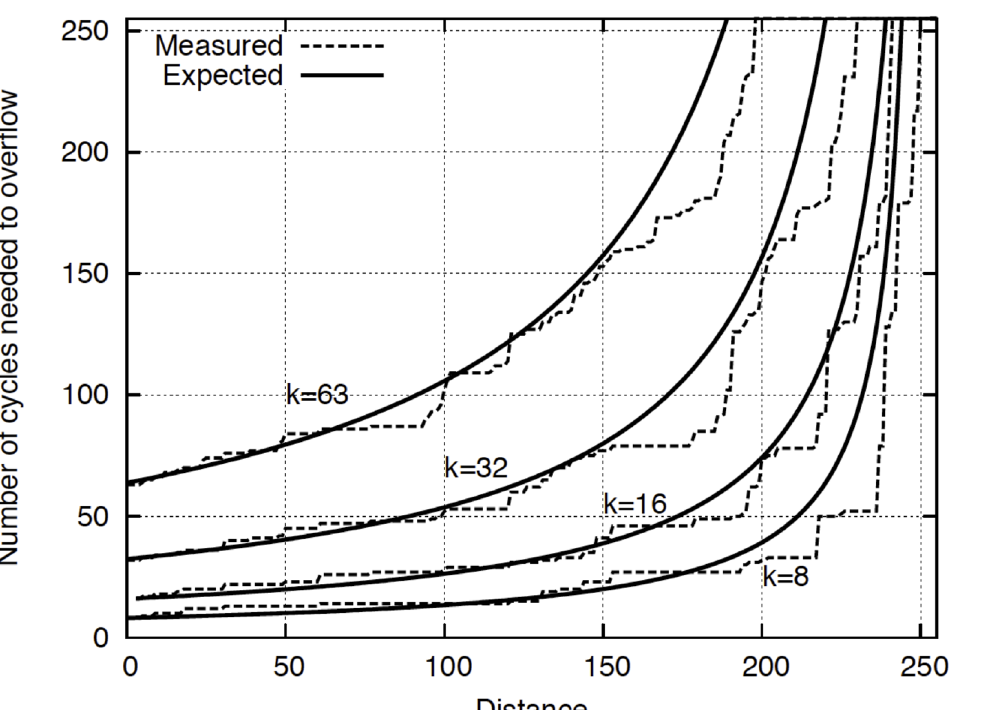
Fig 10. Relationship of distance between vectors (| x-y |) and the number of cycles needed to overflow a module-k counter of the WTA. The switching activity of the similarity stochastic signal ( s jr ) is dependent on the distance ( s = 1-d ). As the higher is the distance, lower will be the switching activity of s , and higher the number of cycles needed to overflow the